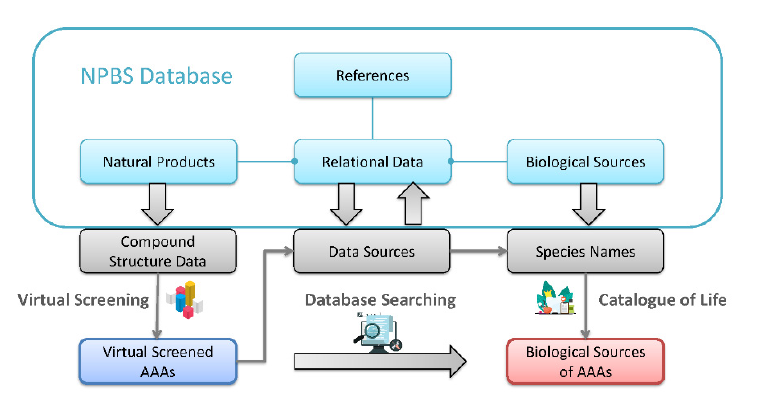
Figure 2. The process flow diagram of obtaining information data of biological sources containing aristolochic acid ana- logues.